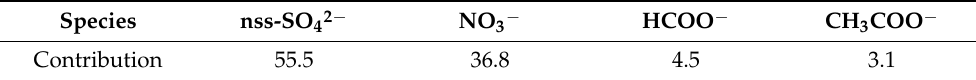
Table 5. Acidification contributions (%) of acidic anions in